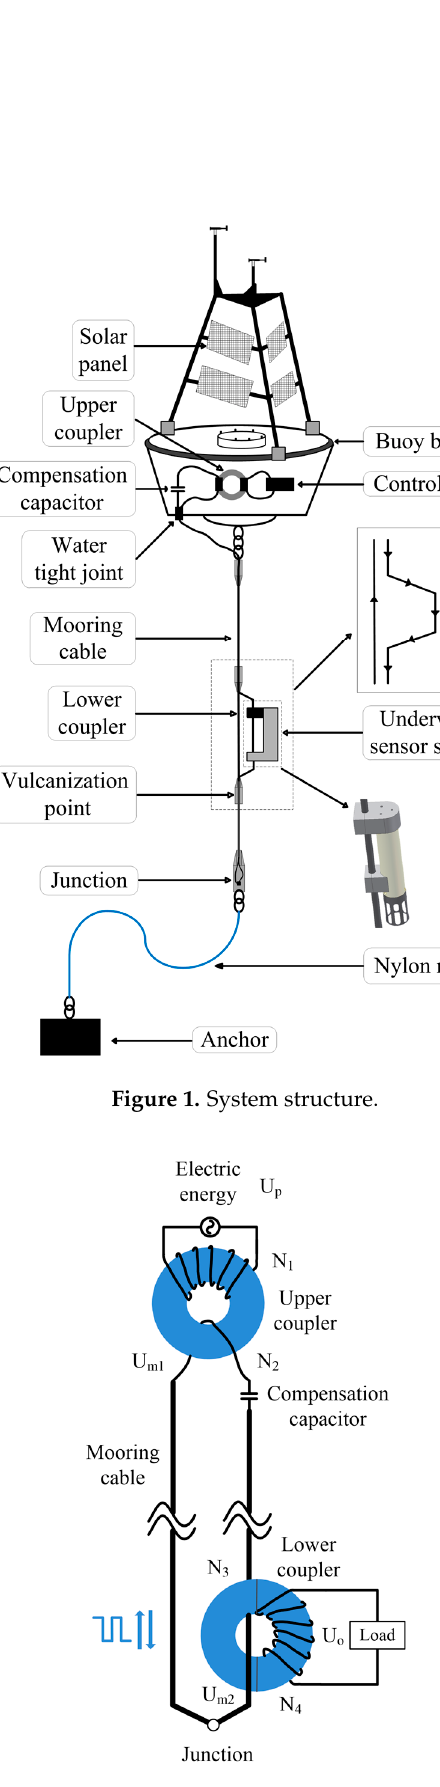
Figure 2. System Figure 2. System principle . Figure 2. System principle .